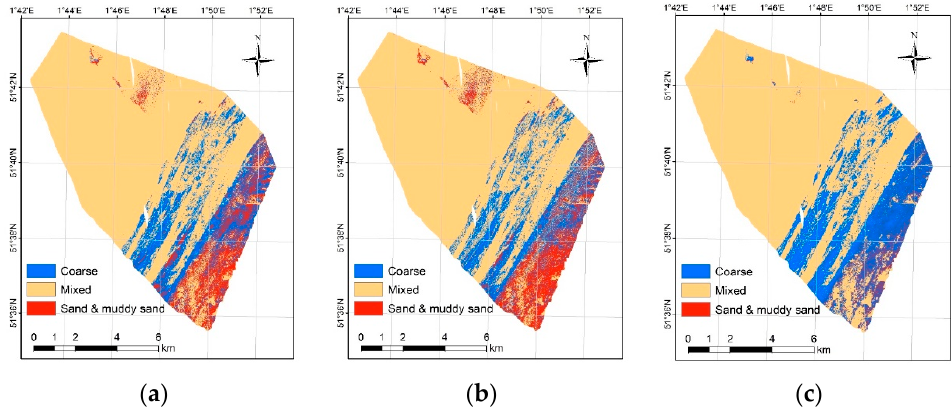
Figure 13. Three decision fusion results based on different traditional classifiers in S1. ( a ) RPNet-RF; ( b ) RPNet-KNN; ( c ) RPNet-SVM.